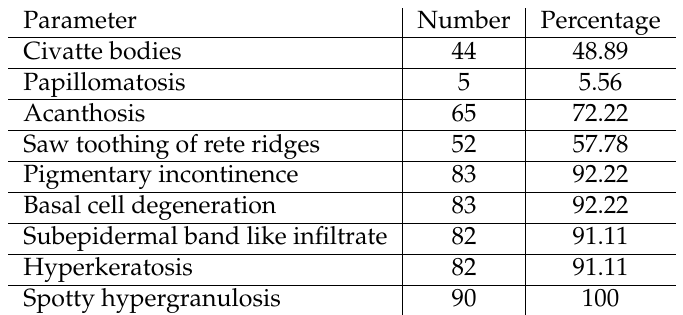
Table 5. Histological findings in of cutaneous LP Parameter Number